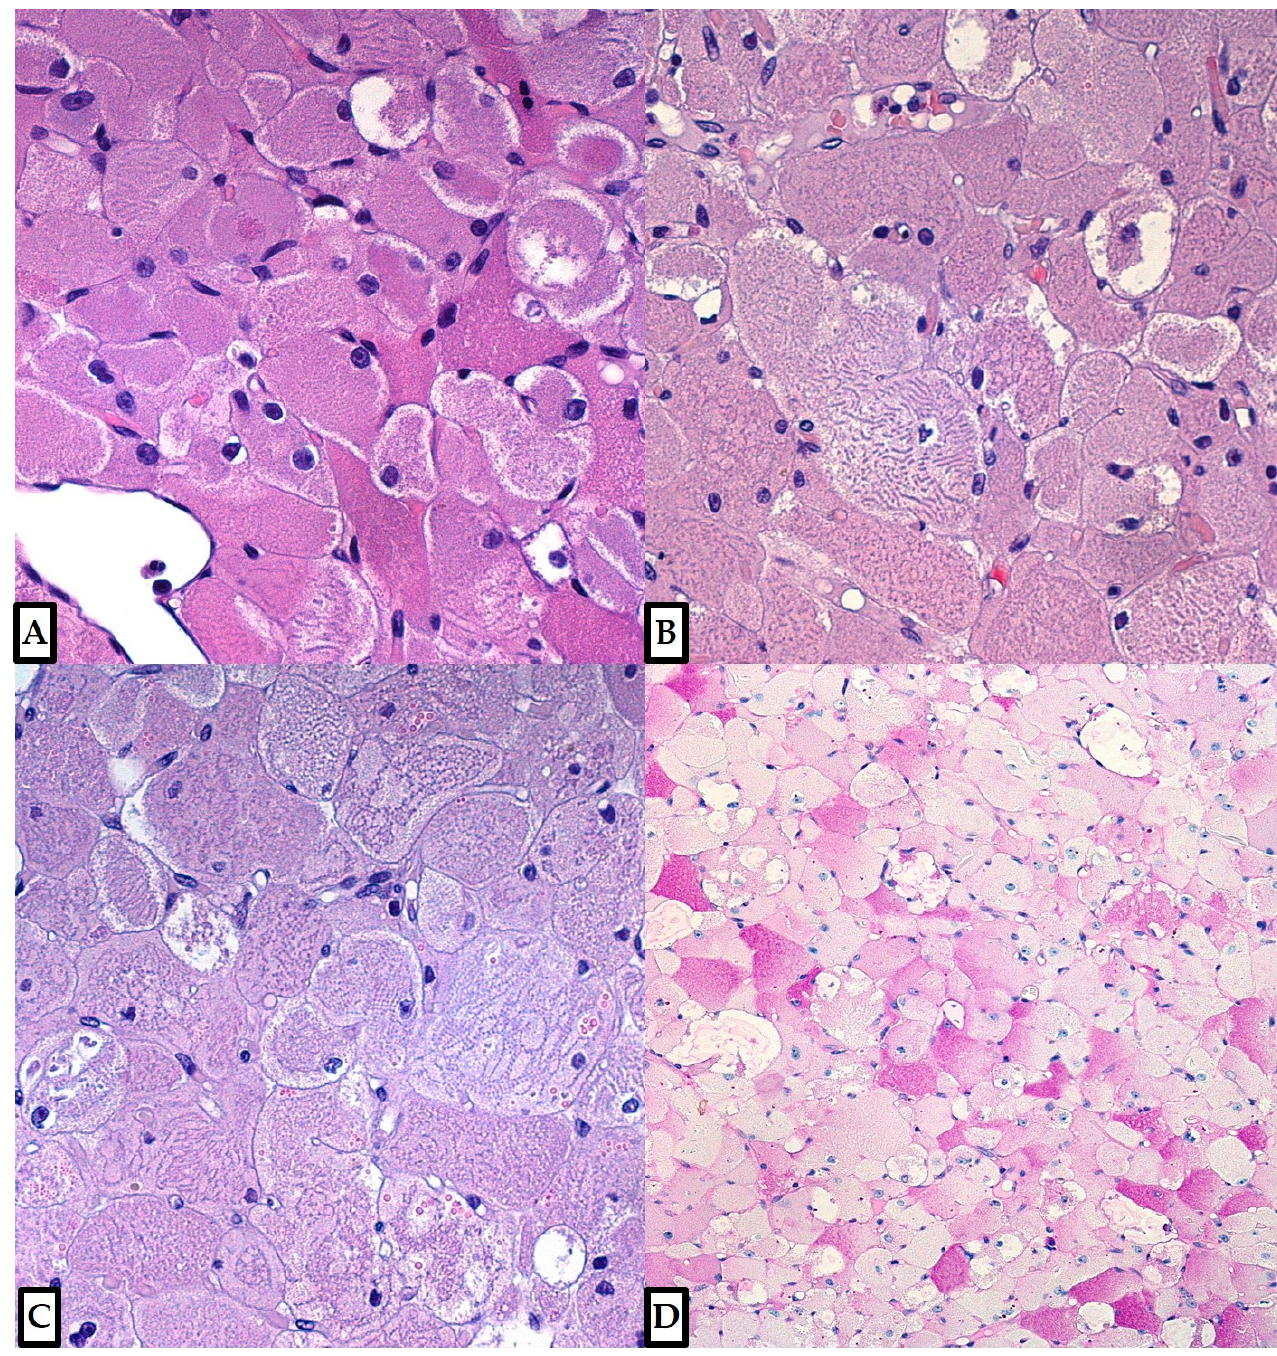
Figure 5. On higher power, cytoplasmic rod-like inclusions and often subtle cross striations were present in many cells (( A – C ); Hematoxylin and Eosin, 20×; previously unpublished, original photos), being more subtle in some areas (as in Figure 5A). Periodic Acid–Schiff (PAS) stain showed variable cytoplasmic positivity (( D ); 10×; previously unpublished, original photo), while PAS-diastase reaction resulted negative.